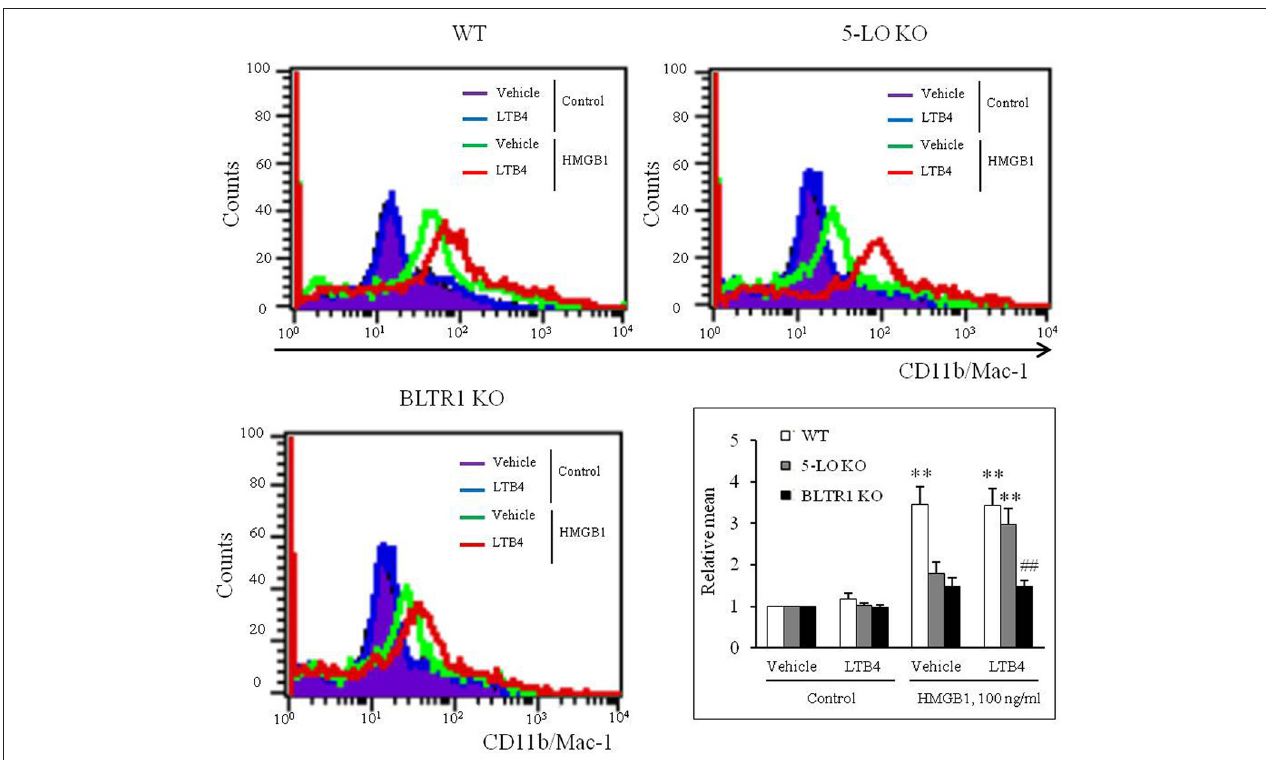
FIGURE 4 | Role of LTB4-BLTR1 signaling in monocytes on HMGB1-induced MMD. Representative flow cytometric images of CD11b/Mac-1 expression in HMGB1-stimulated BMDCs in the presence or absence of exogenous LTB4. BMDCs isolated from wild-type (WT), 5-LO-deficient (KO), and BLTR1-KO mice, were incubated with LTB4 (10ng/ml) for 1h, and then treated with HMGB1 (100ng/ml) to induce MMD. The cellular expressions of CD11b/Mac-1 were determined by flow cytometry. Bottom right: Differential CD11b/Mac-1 expressions in interface flow cytometric images were quantified, and data were presented as the means ± SEMs of 8–9 independent experiments. ** P < 0.01 vs. corresponding value in control, ## P < 0.01 vs. corresponding value in WT